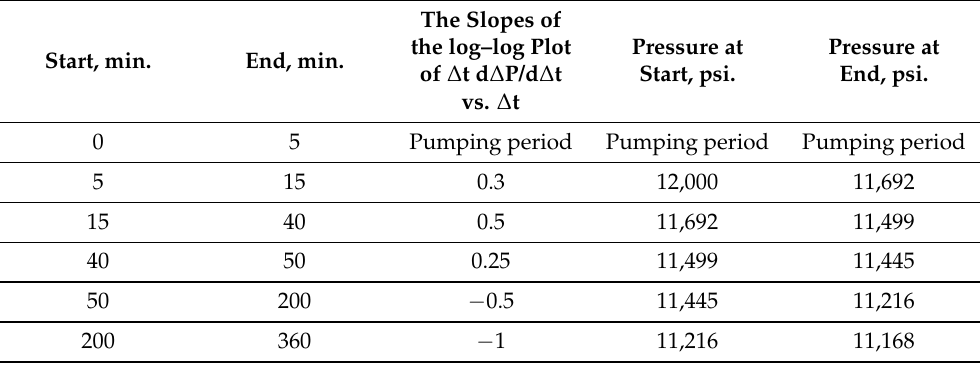
Figure 16. ( a ) Normal leak off log–log plot; ( b ) pressure-dependent leak off log–log plot; and ( c ) tip extension log–log plot (Barree et al. (2009) [26]). Table 2. The slopes of the log–log plot of ∆ t d ∆ P/d ∆ t vs. ∆ t for the reverse-calculated pressure decay